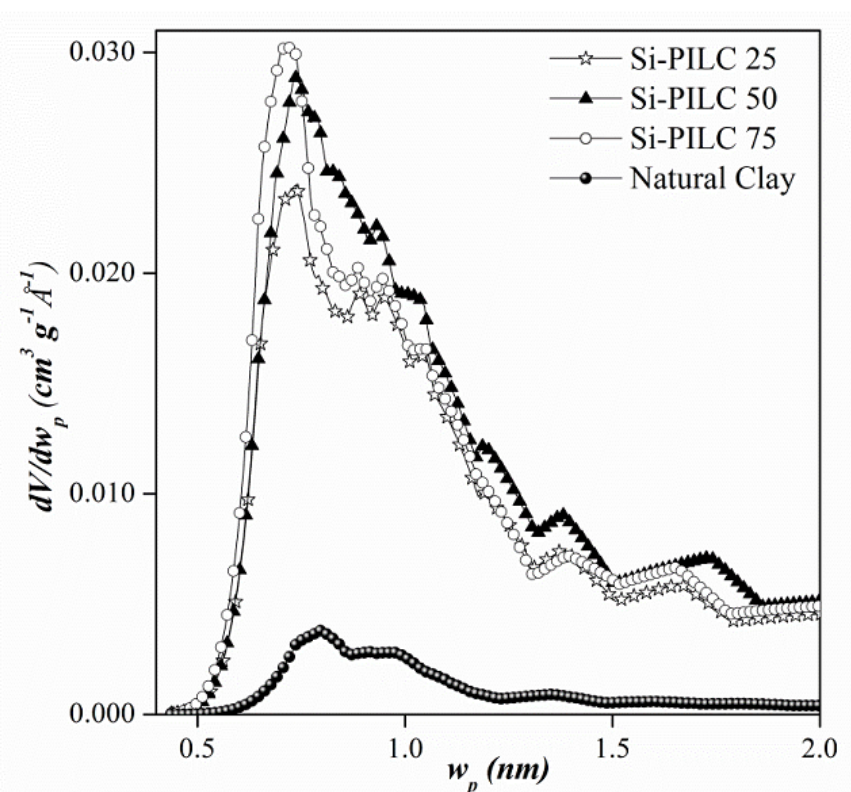
Figure 4. Pore size distribution (PSD) of natural and pillared clay